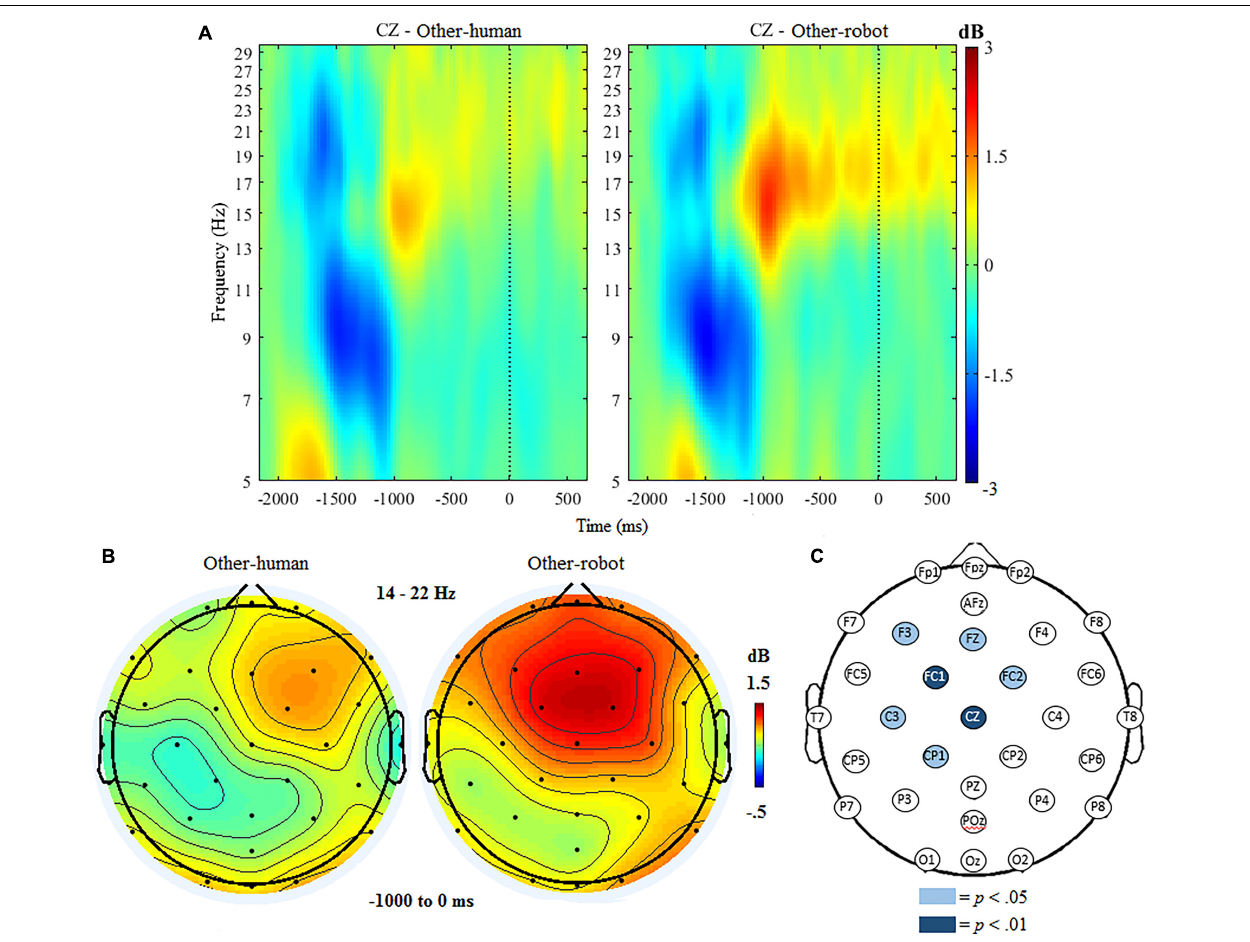
FIGURE 4 | (A) Event-related spectral perturbation at electrode Cz during other trials, with beta ERS present the time window following the button press (–1000 to 0 ms). Human-other and robot-other conditions are shown separately. (B) Topographic maps showing condition differences for post-button press activity in the beta band (14–22 Hz) from –1000 to 0 ms, with 0 ms being time locked to the participant’s button press. (C) Differences in beta power increase between human and robot conditions in the other trials. Significantly different electrodes are highlighted, showing differences in beta ERSP over central sites based on paired samples t -tests. The nose is located at the top of the scalp